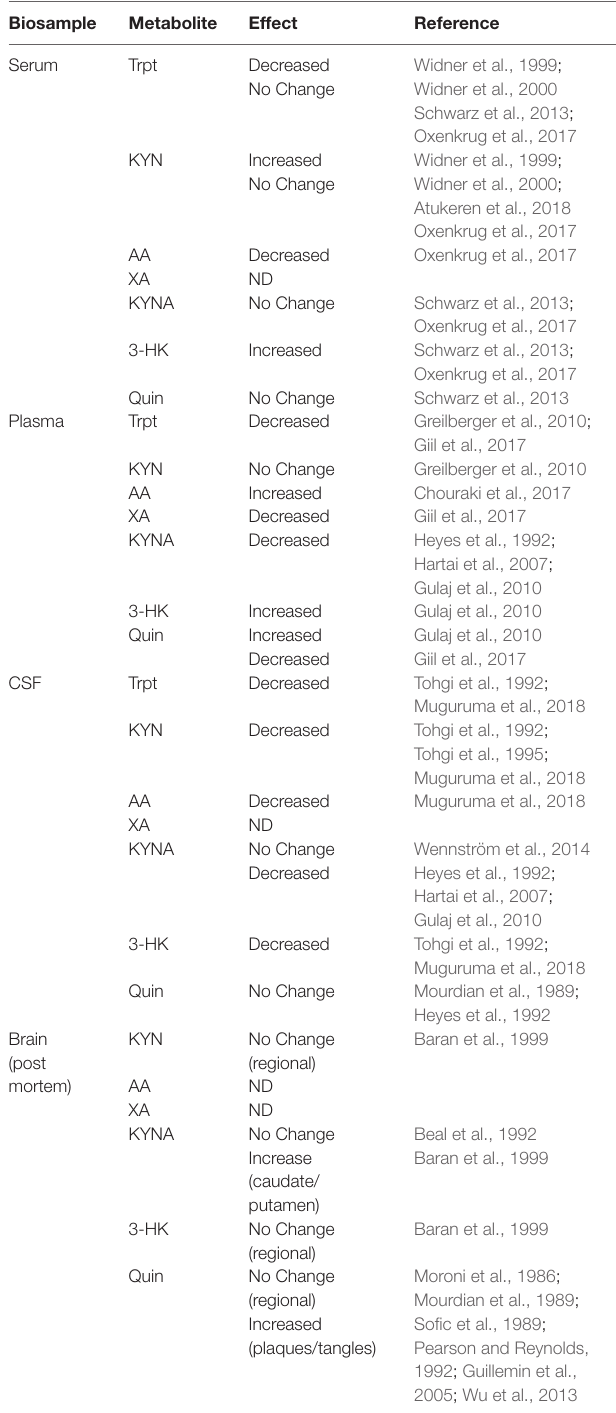
TABLE 1 | Kynurenine metabolite profile from patients with Alzheimer’s Disease.